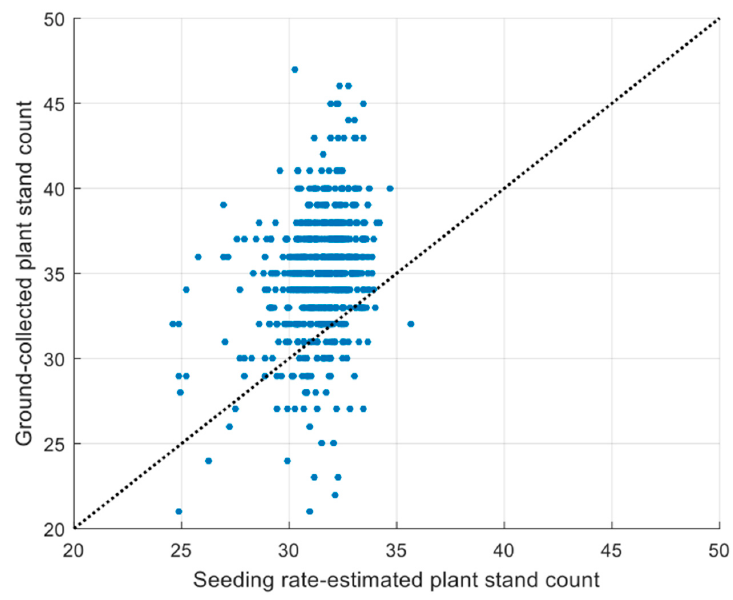
Figure 12. Seeding rate-estimated vs. ground-collected plant stand count in the field trial. This figure shows that the estimated stand count was in general smaller than that collected manually in the field.